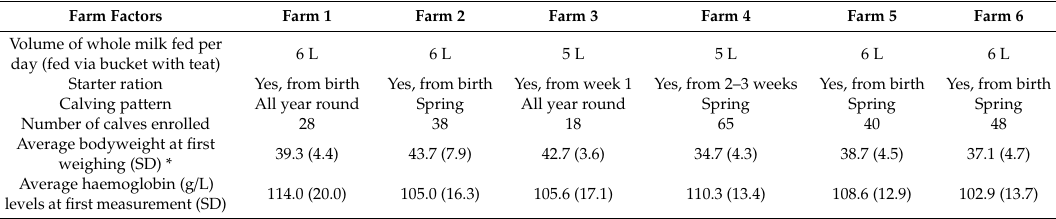
Table 1. Details of farms enrolled, volume of milk and ration fed, calving pattern, number of calves enrolled and starting haemoglobin levels and bodyweight values. Farm Factors Farm 1 Farm 2 Farm